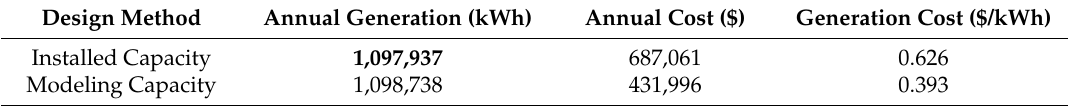
Table 9. Economic comparison of operation costs by estimated load pattern for Island 5.